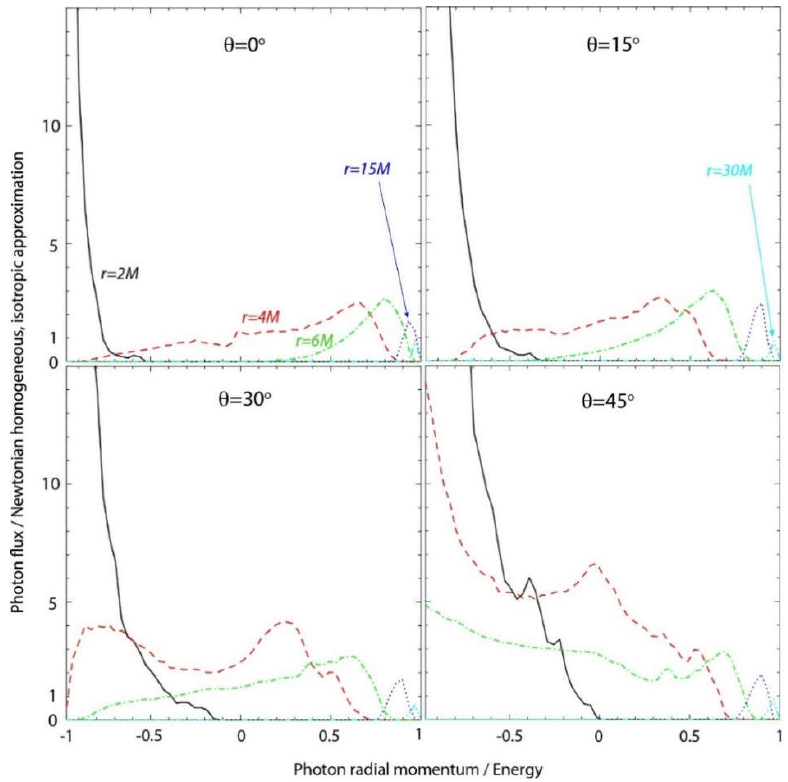
Figure 10. Advection-dominated accretion flow (ADAF) photon flux correction factor, f ADAF , as a function of the cosine of the propagation direction, cos θ γ ZAMO , with respect to the radially outward direction, at five discrete radial positions at three latitudes, as labeled. BH spin is assumed to be 0 .9 M . The black solid, red dashed, green dot-dashed, blue dotted, and cyan triple-dot-dashed curves denote f ADAF at r = 2 M , 4 M , 6 M , 15 M , and 30 M , respectively. In each panel, the abscissa changes from cos θ γ ZAMO = − 1 to + 1; − 1 corresponds to the radially inward direction, whereas + 1 does radially outward direction in the zero-angular-momentum observer (ZAMO). From [63].